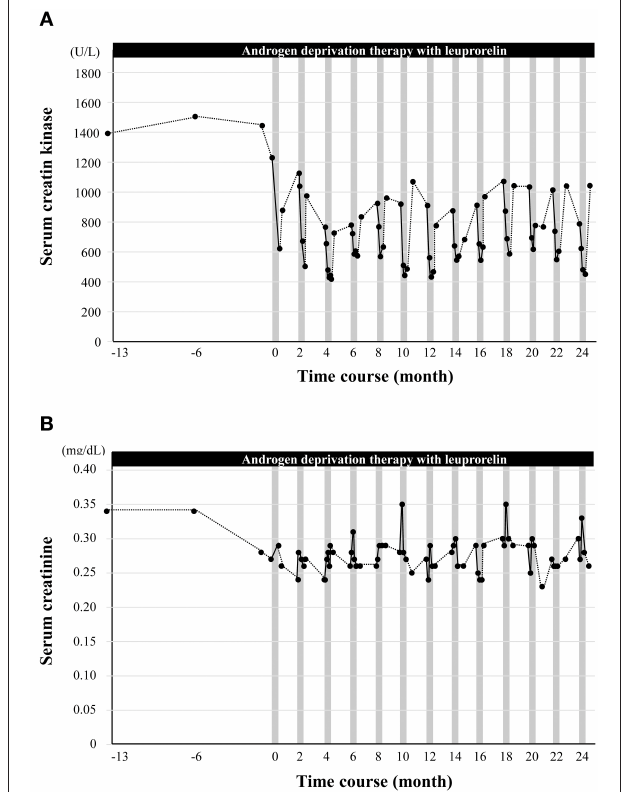
FIGURE 3 | The effect of cybernic treatment with a hybrid-assisted limb (HAL) on the serum levels of creatine kinase and creatinine. (A) The black dots indicate the serum levels of creatine kinase. (B) The black dots indicate the serum levels of creatinine. Vertical gray bars indicate one course of cybernic treatment with